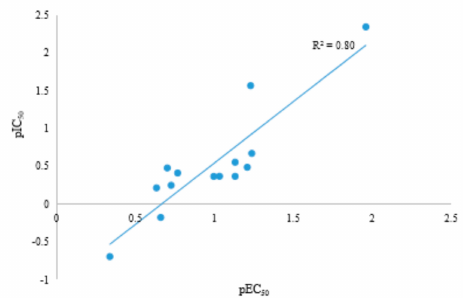
Figure 3. Regression analysis of pIC 50 vs. pEC 50 values for CN-biphenyl DAPYs and the reference compounds NVP and